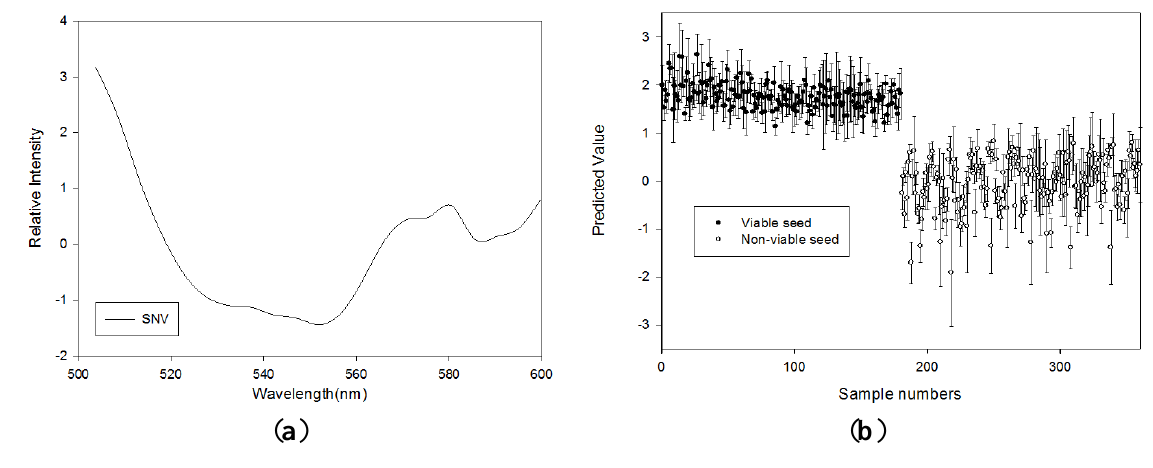
Figure 5. ( a ) Regression coefficients of the PLS-DA model, and ( b ) the PLS-DA prediction results obtained using SNV to discriminate between viable and nonviable pepper seeds based on the reflectance spectra produced under GL (500–600